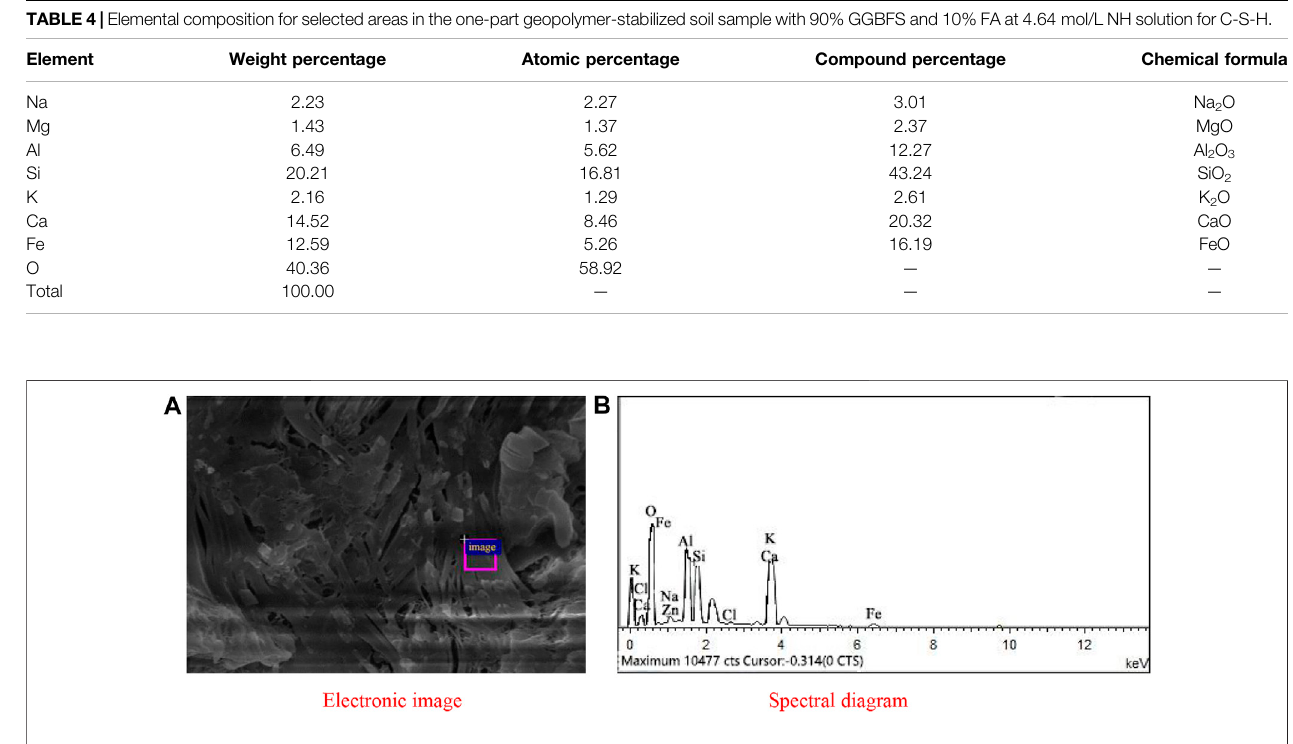
Frontiers in Materials |